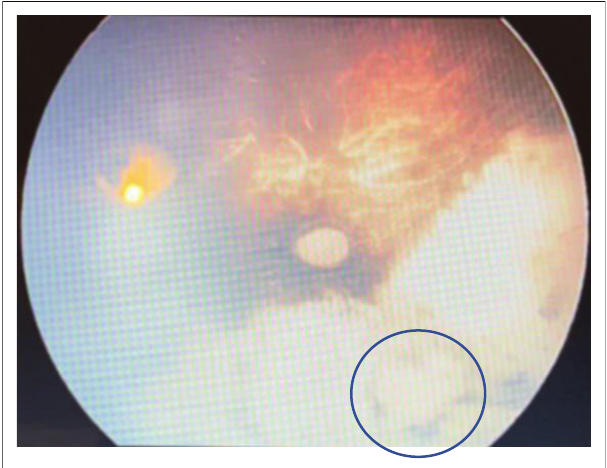
FIGURE 2: RetCam photo showing regressed tumour within the